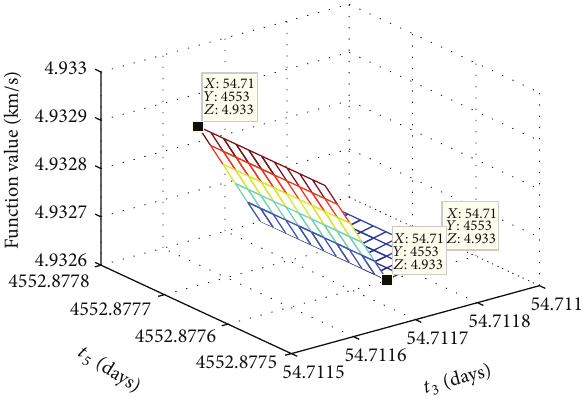
Figure 7: Relationship between function value change and variables 𝑡 𝑡 3 and 5 .